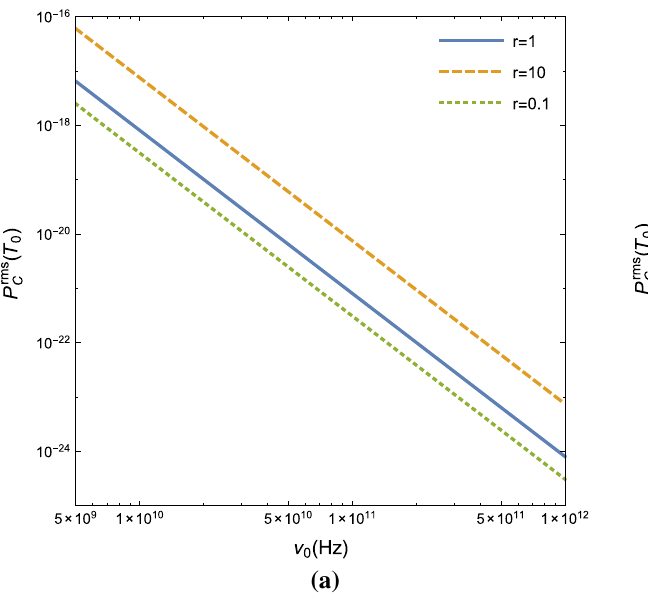
Fig. 3 In a logarithmicscaleplotsoftherootmeansquareofthedegree ( T ) as a function of the CMB frequency ν of circularpolarization P rms 0 C for a value of B e 0 = 10 − 10 G and | r | = 0 . 1 , 1 , 10 are shown. In b loga- rithmicscaleplotsoftherootmeansquareofthedegreeofcircularpolar-